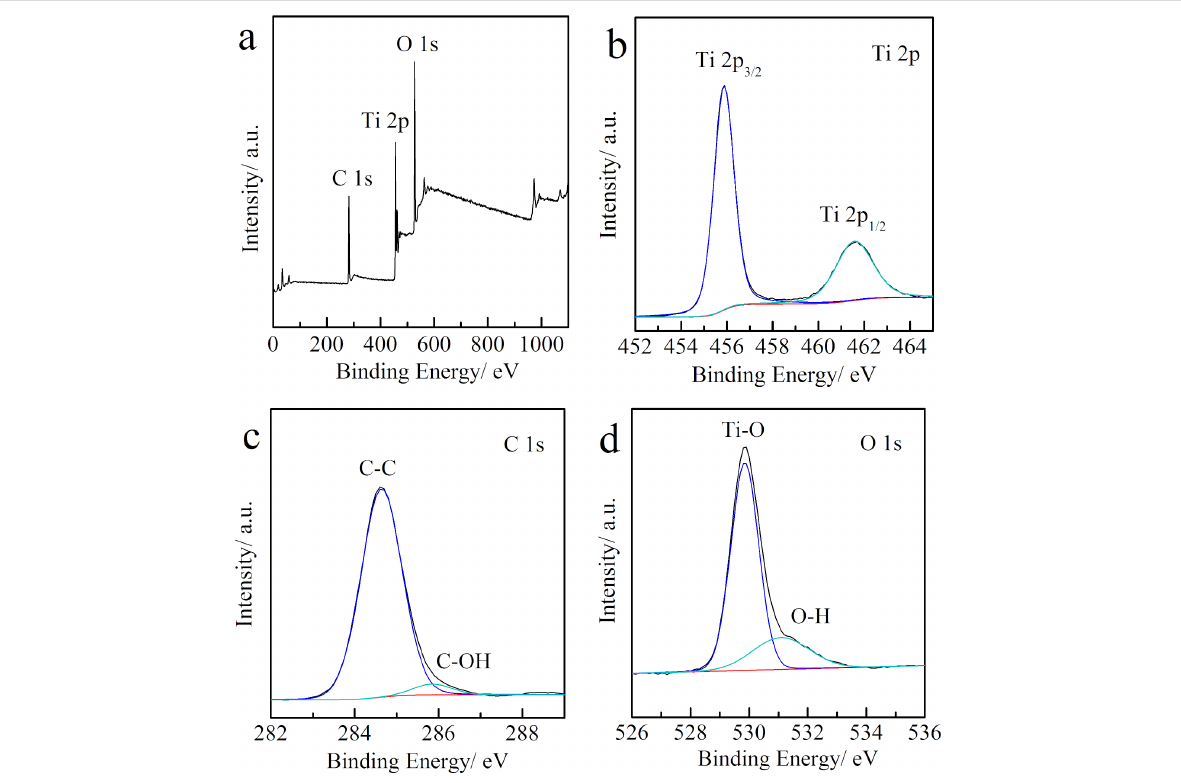
Figure 5: (a) XPS survey spectrum and core level XPS spectra of (b) Ti 2p, (c) C 1s, and (d) O 1s for sample TGN-branch 4 h.